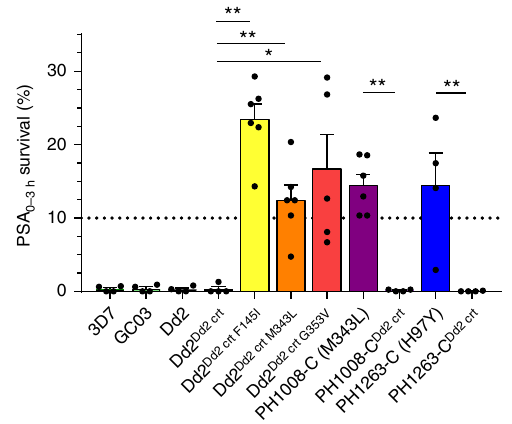
Fig. 2 The PfCRT mutations H97Y, F145I, M343L, and G353V confer PPQ resistance. When edited into to a PPQ-sensitive Dd2 pfcrt background, F145I, M343L, and G353V each conferred PPQ resistance, as determined using the in vitro PSA 0 – 3h . In this PPQ survival assay, tightly synchronized ring-stage parasites were exposed to 200 nM PPQ for 48 h, followed by removal of drug and further culture incubation for 24 h. Survival rates were determined as a percentage of the parasitemia obtained with each line mock-treated with drug vehicle, and are presented as means± SEM. When H97Y or M343L were removed from the contemporary Cambodian fi eld isolates PH1008-C and PH1263-C, PPQ resistance was fully ablated. N , n = 2 – 4, 2 (Supplementary Table 4). Signi fi cance was determined using Mann – Whitney U tests. Comparisons are shown between pfcrt -edited parasites and their isogenic controls. * p < 0.05; ** p <